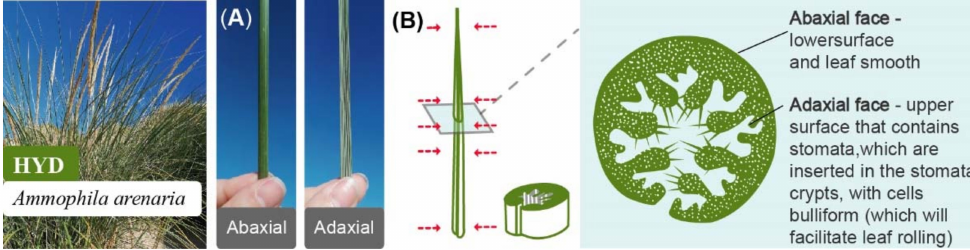
Figure 3. Characteristics of A. arenaria . ( A , B ) abaxial and adaxial face. Source: adapted by